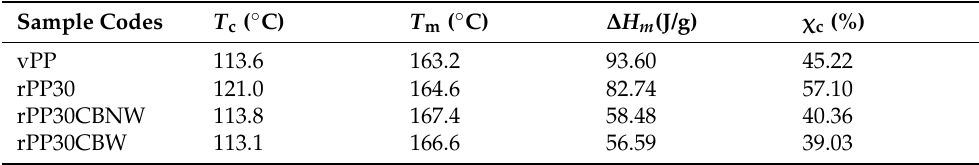
Table 4. Summarized results of DSC analysis of vPP, rPP30 and its composites. Sample